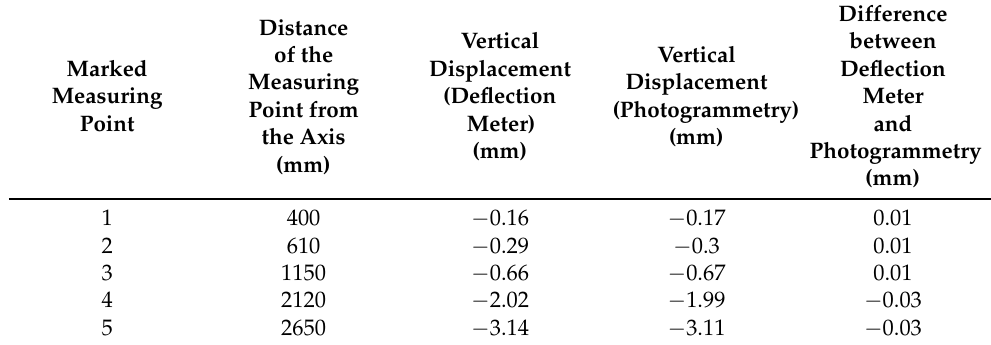
Table 5. Comparison of results measured with a deflection meter and photogrammetry.